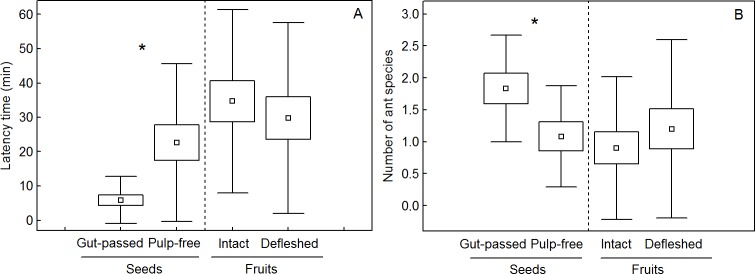
Ants interacting with Miconia irwinii diaspores on the ground of campo rupestre vegetation.(A) Latency time (time elapsed between placing diaspores on the ground and the first interaction with ants) across different experimental treatments. (B) Number of ant species interacting with diaspore piles. Squares represent mean, boxes standard error and whiskers standard deviation), asterisk denotes significant differences (Paired t test—p < 0.001).